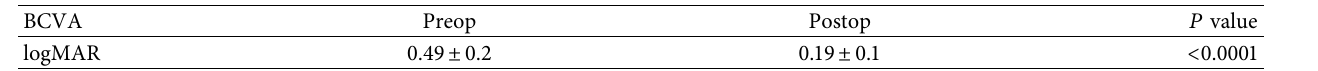
Table 3: Mean preop and postop mean visual acuity.